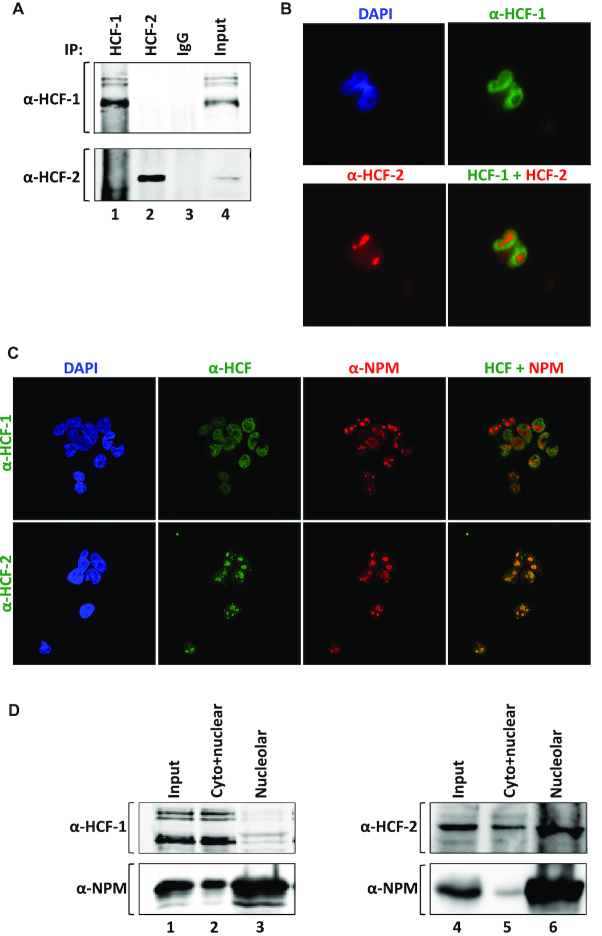
HCF-1 and HCF-2 display different subnuclear localization. (A) α-HCF-1 (top) and α-HCF-2 (bottom) immunoblot of protein complexes after immunoprecipitation from a MEF whole-cell extract with α-HCF-1 antibody (lane 1), α-HCF-2 antibody (lane 2) or non-immune IgG (lane 3). Lane 4, starting whole-cell lysate. (B) HEK-293 cells co-stained with mouse monoclonal α-HCF-1 (green) and rabbit polyclonal α-HCF-2 (red) antibodies. Left, nuclear staining with DAPI (blue); right, merge of individual HCF-1 and HCF-2 signals. (C) Co-immunostaining of HEK-293 cells with α-NPM antibody (red) and either polyclonal rabbit α-HCF-1 antibody (green, upper panels) or α-HCF-2 antibody (green, lower panels). Left panels, nuclear staining with DAPI (blue). Right, merge of NPM and HCF signals. (D) Immunoblot of samples after nucleolar fractionation of HEK-293 cells with HCF-1, HCF-2, and NPM antibodies as indicated. Lanes 1 and 4, starting whole-cell lysate; lanes 2 and 5, cytoplasmic and non-nucleolar fraction; lanes 3 and 6, nucleolar fraction.